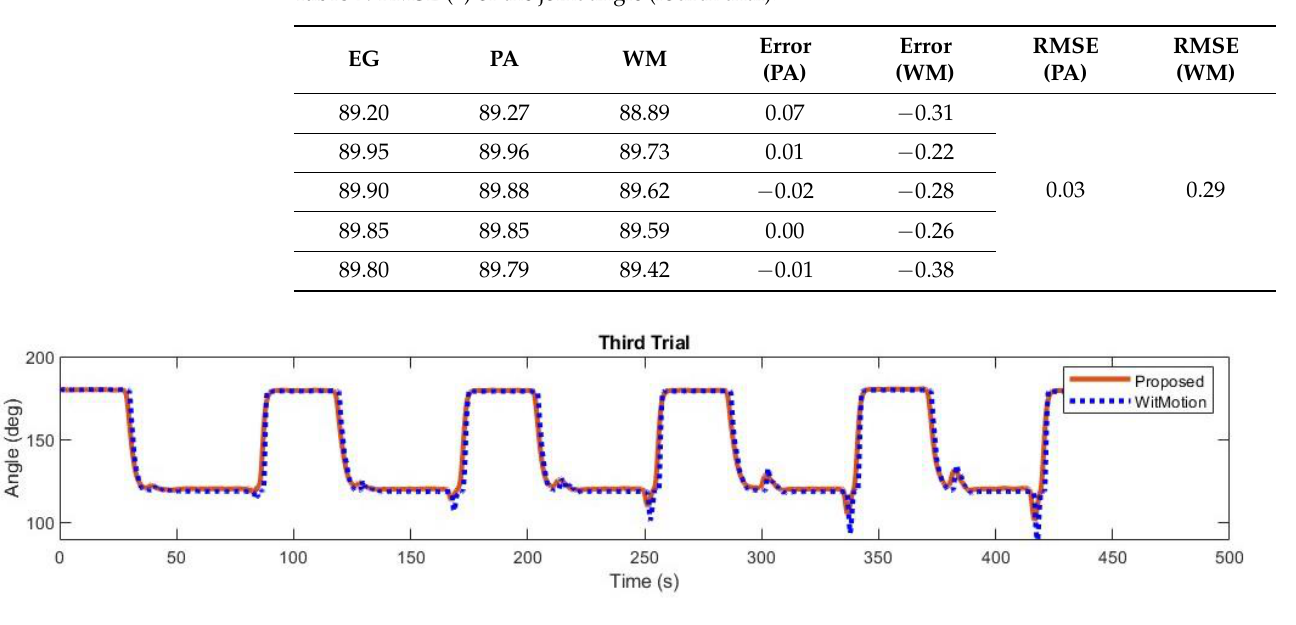
Table 7. RMSE ( ◦ ) of the joint angle (fourth trial).